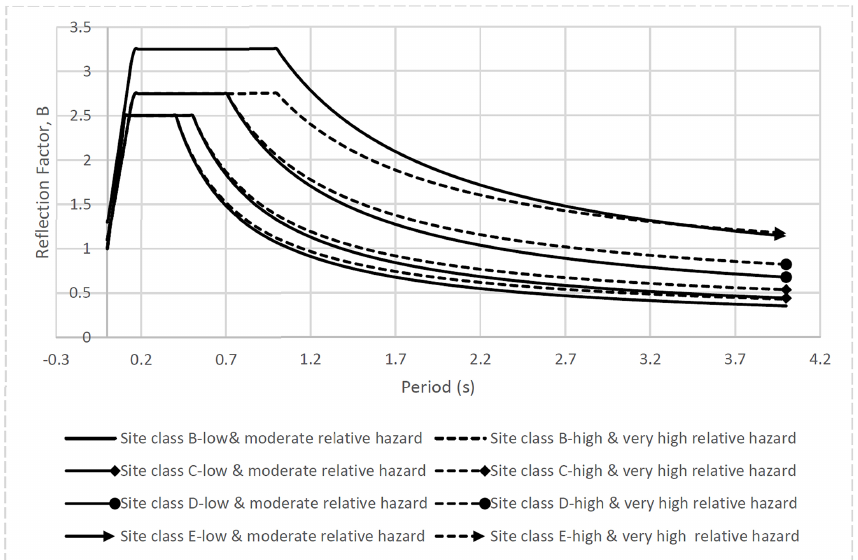
Figure 6. Reflection factor spectra for different soil types and seismicity levels.